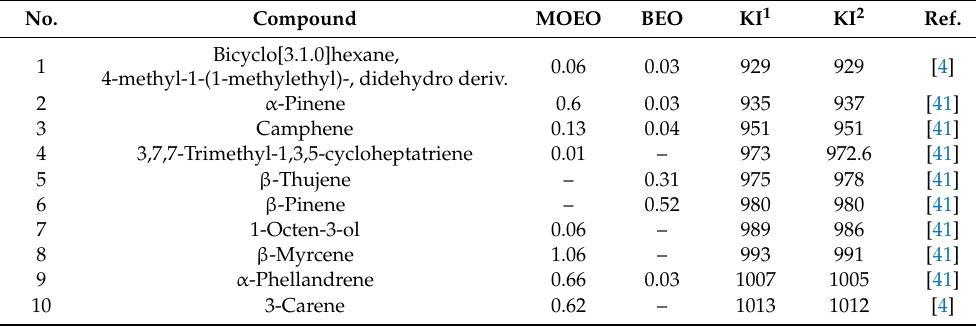
Table 1. Mexican oregano (MOEO) and basil (BEO) essential oil composition (%